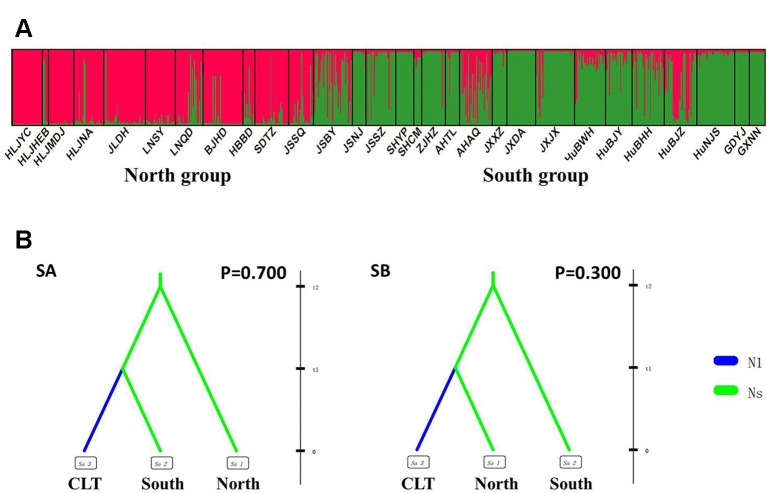
Genetic structure and settings of two competing scenarios in the wild Zizania latifolia populations. (A) Genetic structure of wild populations illustrated by STRUCTURE. Each vertical bar represents an individual, and each color represents a cluster in the histograms of STRUCTURE. (B) Two competing scenarios for ABC simulations. CLT is the cultivated group, South is the south group, and North is the north group. These groups were assumed to be isolated from each other, with no exchange of migrants. In Scenario A (SA), the southern group was separated from the northern group at time scale t2, with no changes in effective population size; at time scale t1, the cultivated group was then separated from the southern group and went through a bottleneck with an effective population size change from Ns to N1.